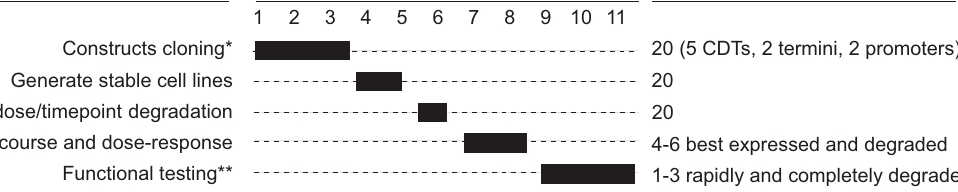
and inactivation of the gene upon degrader drug addition. b A proposed timeline for evaluating the expression, degradation, and function of CDT fusions. Although 20constructscanallbetestedinparallelusingthevectorsandprotocolspresented here, priority can be given to particular CDTs if required (see Discussion). In most cases, a degraded and functionally relevant CDT fusion protein can be developed within 11 weeks. *Construct cloning via Contract Research Organization; **Func- tional testing is highly target-dependent and 3 weeks is an